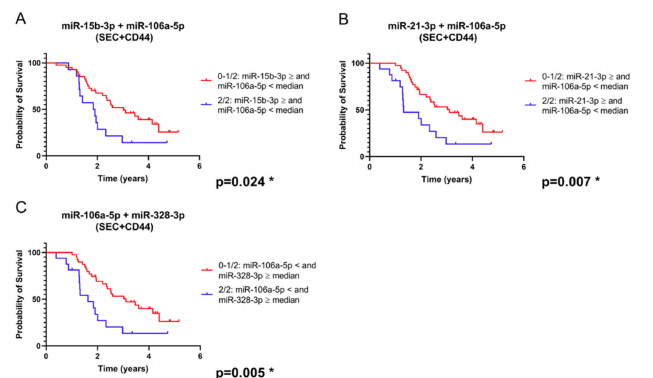
Figure 7. Survival analysis based on the expression of a combination of microRNAs isolated from SEC + CD44 EV (combinations: miR-106a-5p plus ( A ): miR-15b-3p; ( B ): miR-21-3p in SEC + CD44 EVs; ( C ): miR-328-3p). Depicted are survival curves using a dichotomous assessment based on a combination of microRNA levels from glioblastoma patients ( n = 55) in SEC + CD44 separated serum EVs. Blue color indicates patients whose microRNA profile fulfils both conditions, while red color indicates patients whose profile fulfils at most one out of two conditions. Note that the combination of miR-106a-5p with each of the other three microRNAs allowed for a prognostic stratification of this patient population, even after Benjamini–Hochberg correction for multiple testing (Tables S3 and